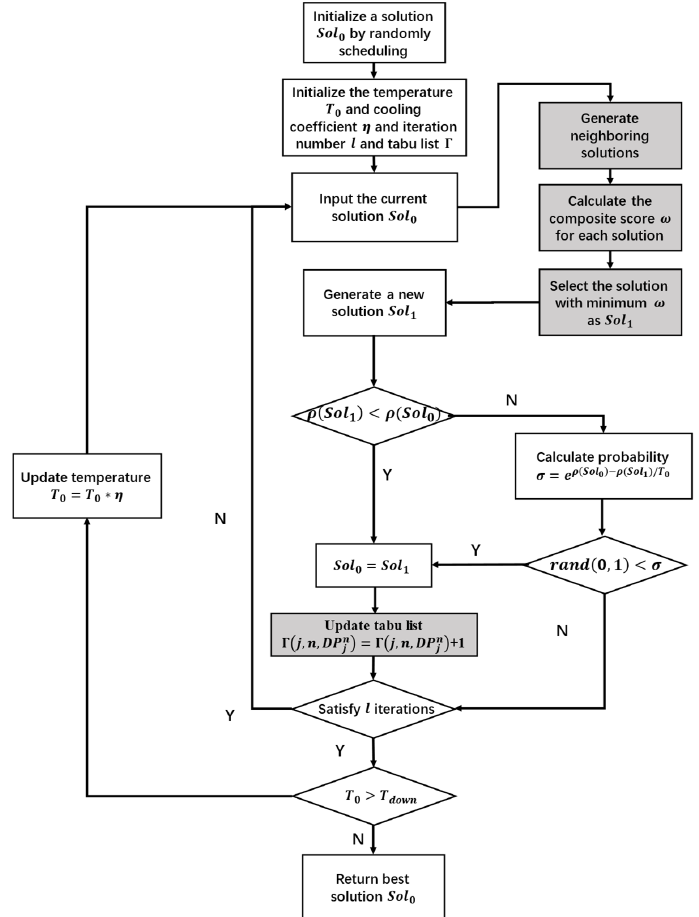
Fig.7. The main process of hybrid heuristic